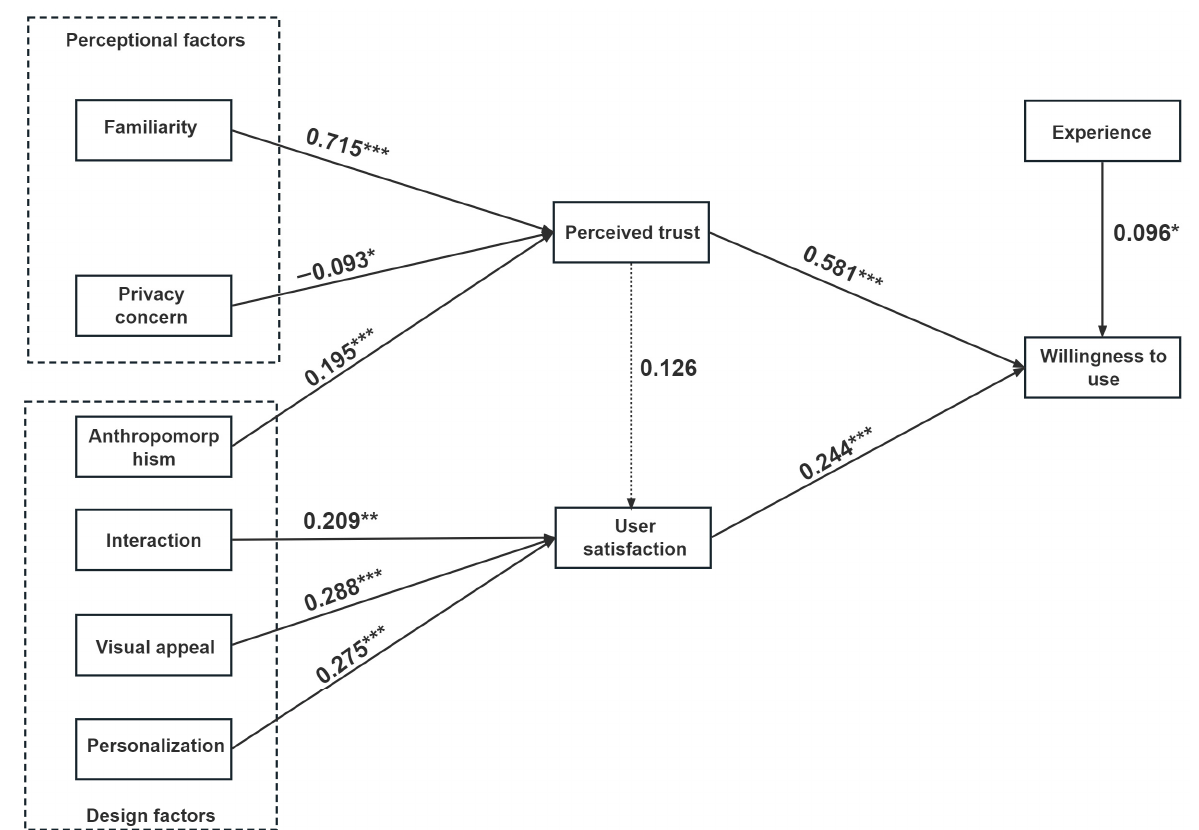
Figure 2. The path analysis results. Note: * p < 0.05; ** p < 0.01; *** p < 0.001.